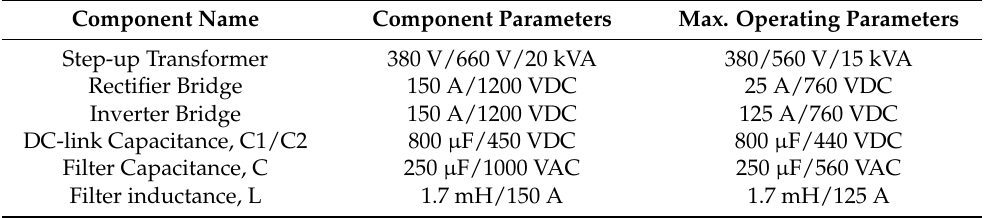
Table 6. The test prototype